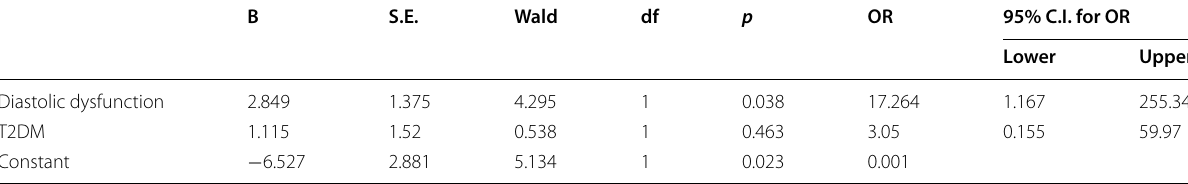
Table 4 Binary logistic regression model for